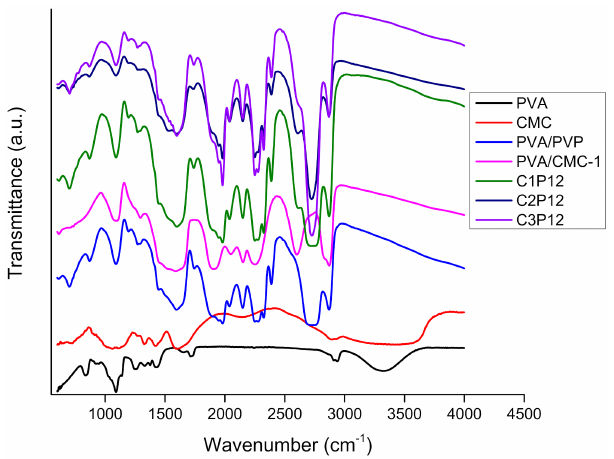
Figure 1. FTIR-ATR spectra of PVA, CMC, PVA/PVP, and tricomponent PVA/PVP/CMC electrospun nanofibers (all spectra are shifted vertically for